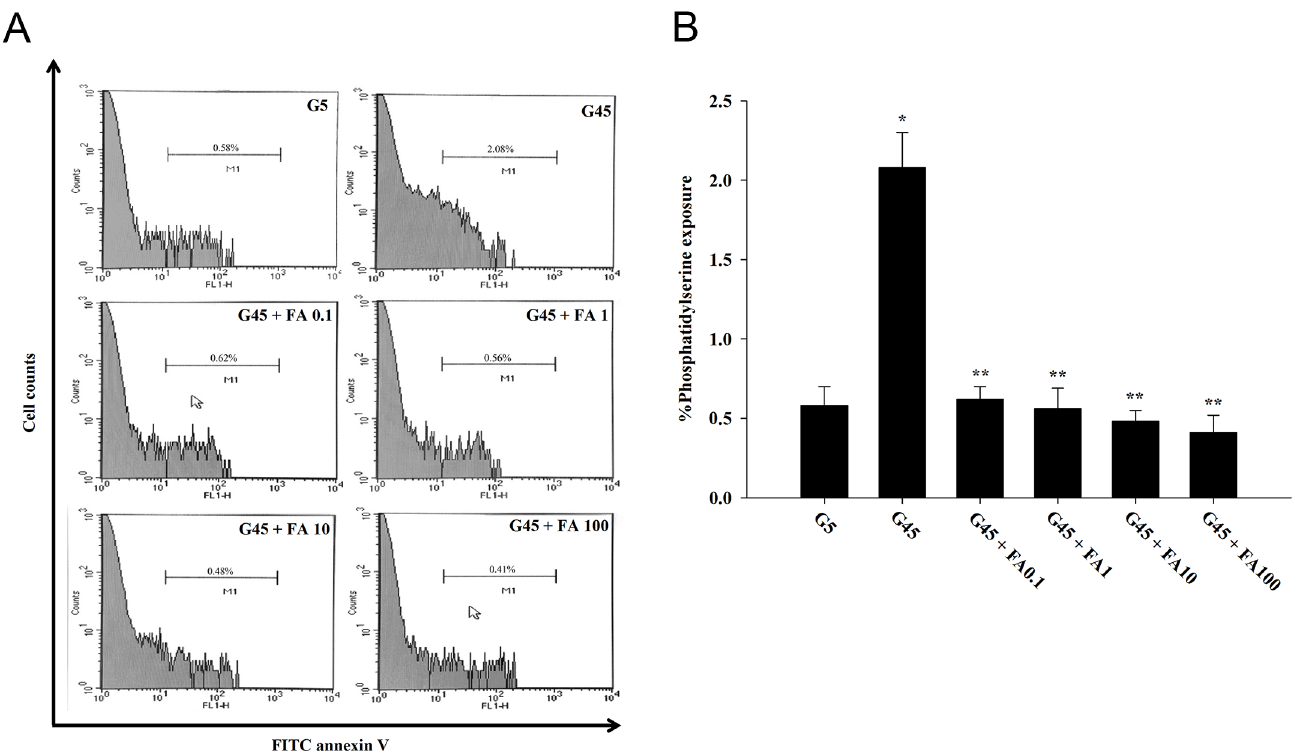
Fig 5. The effects of ferulic acid (0.1 – 100 μ M) on phosphatidylserine exposure (A) and their percentages (B) in erythrocytes treated with 45 mM glucose. The results are expressed as mean ± SEM ( n = 6). * p < 0.05 compared to 5 mM glucose (G5) and ** p < 0.05 compared to 45 mM glucose (G45)